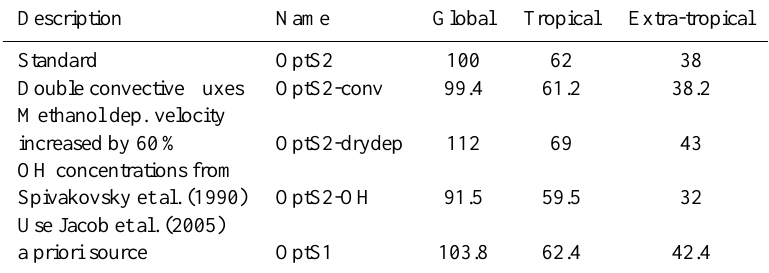
Table 3. Performed sensitivity inversions, and corresponding tropical, extratropical and global biogenic methanol source expressed in Tgyr − 1 .